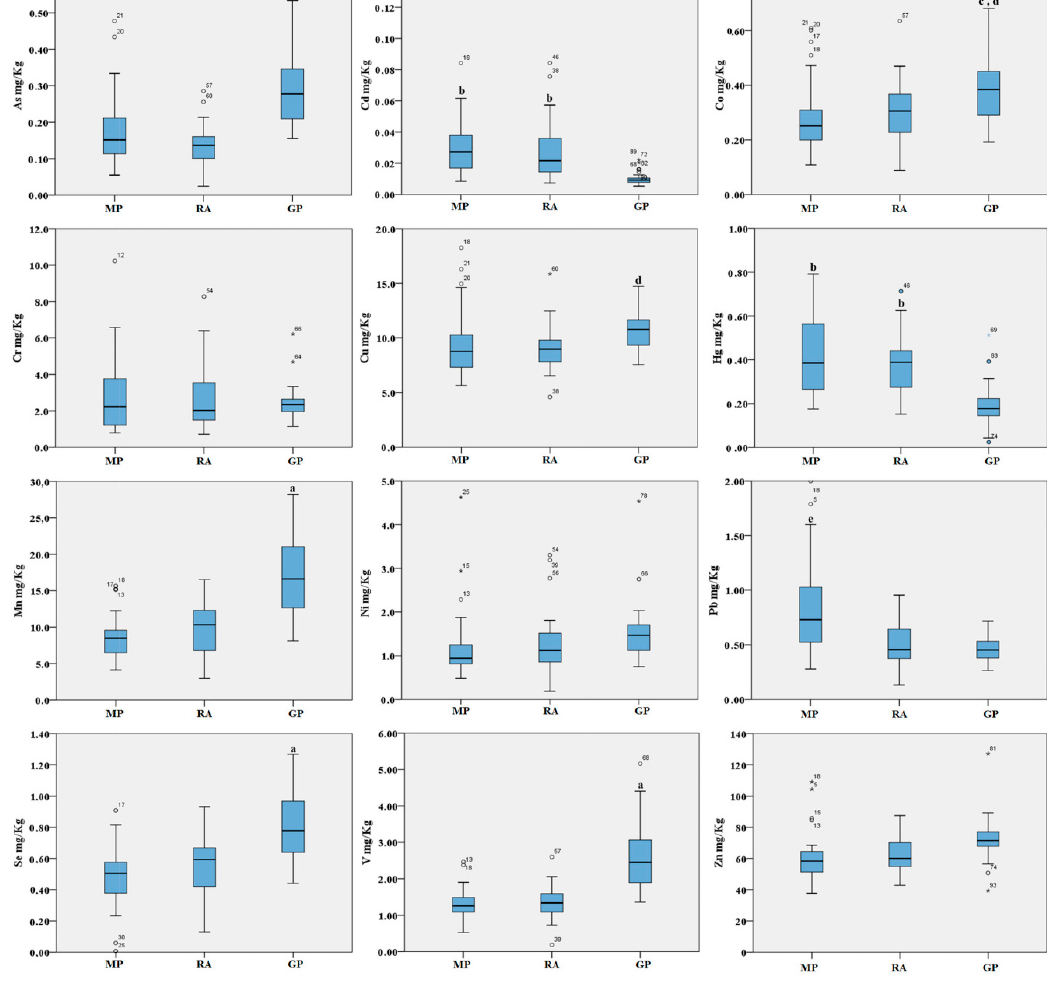
Figure 1. Boxplot of the trace elements in the abrased back feathers (mg/kg d.w.) of birds from the three areas. MP: Magnisi peninsula; RA: Ragusa agro-ecosystem; GP: Gela plain. The box represents the interquartile (IQ) range and contains the 1st quartile, the median and the 3rd quartile; whiskers represent extreme values of minimum and maximum; in addition, outliers with values between 1.5 and 3 times the IQ range are displayed. Legend: a = p<0.001 vs MP and RA; b = p<0.01 vs GP; c = p<0.01 vs MP; d = p<0.05 vs RA; e = p<0.001 vs RA and GP.